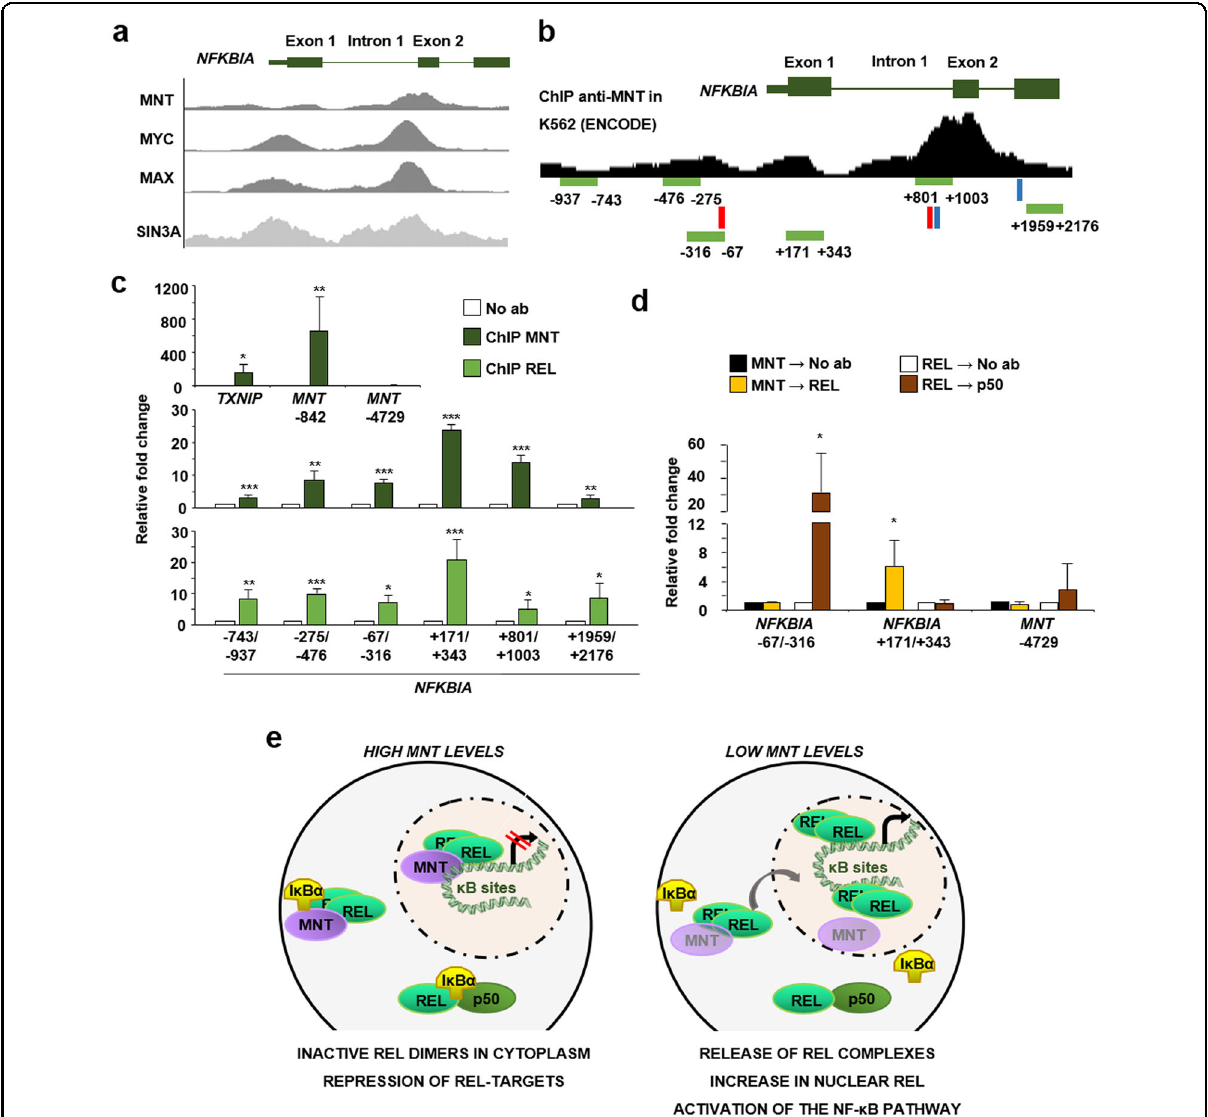
Fig. 6 MNT and REL regulate NFKBIA . a Schematic representation of human NFKBIA (I κ B α ) gene showing the peaks for MNT, MYC, MAX (K562 cell line), and SIN3A (GM78), as published by the ENCODE project consortium (genome-euro.ucsc.edu/). b Schematic representation of human NFKBIA (I κ B α ) gene showing the peaks for MNT binding in the K562 cell line, together with the amplicons analyzed below by ChIP-PCR. The conserved REL- binding sites obtained in the ENCODE project using the TFBS Conserved (tfbsConsSites) track are marked in red rectangles. The E-boxes found in NFKBIA are marked in blue (CACGCG at + 907 bp and CACGTG at + 1899 bp). c ChIP of MNT (upper panel) or REL (lower panel) in LoVo cells on NFKBIA promoter. TXNIP and MNT − 842 used as positive controls and a region upstream MNT promoter ( MNT − 4729), as a negative control for MNT ChIP. The data are shown as the mean ± S.D., n = 3, ** P < 0.05; *** P < 0.01. d Re-ChIP of MNT with REL (MNT → REL) and REL with p50 (REL → p50) in LoVo cells. MNT and REL ChIPs were also re-immunoprecipitated with IgG as a negative control of the technique. The data are shown as the mean ± S.D., n ≥ 3, * P < 0.1. e Model of the MNT regulation of NF- κ B signaling. Our results indicate that in a high MNT-levels condition, MNT would be